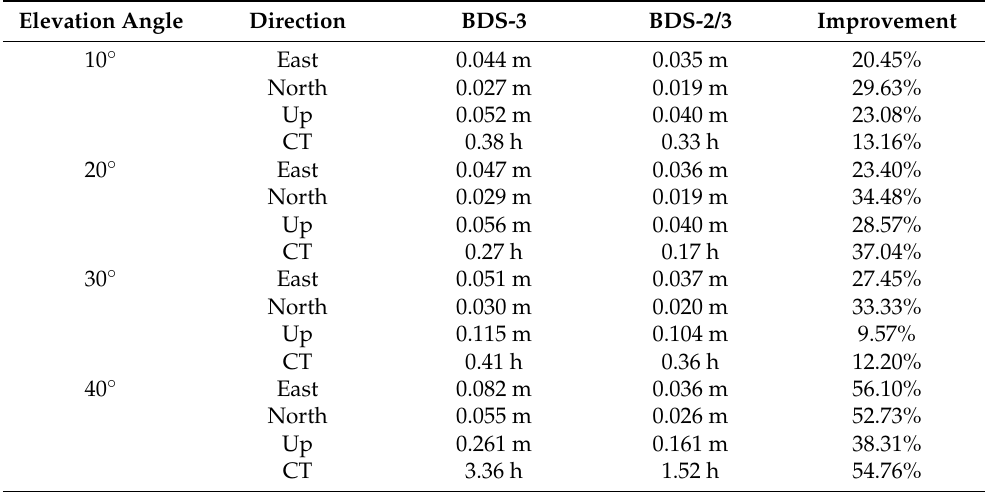
Table 4. Positioning errors (m) and convergence time (h) at JFNG station at different cut-off eleva- tion